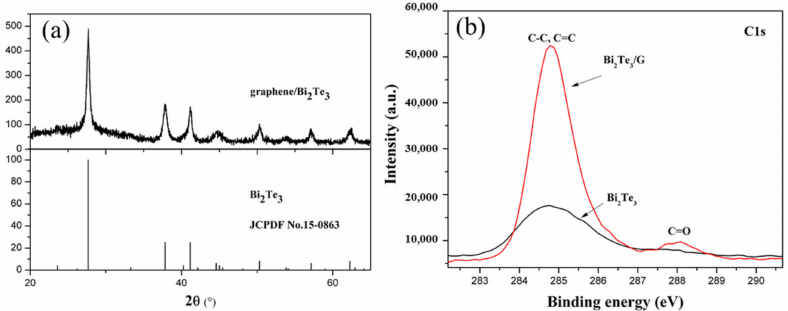
Figure 2. ( a ) XRD of the Bi 2 Te 3 /graphene heterostructure; ( b ) C1s XPS of the Bi 2 Te 3 /graphene heterostructure and Bi 2 Te 3